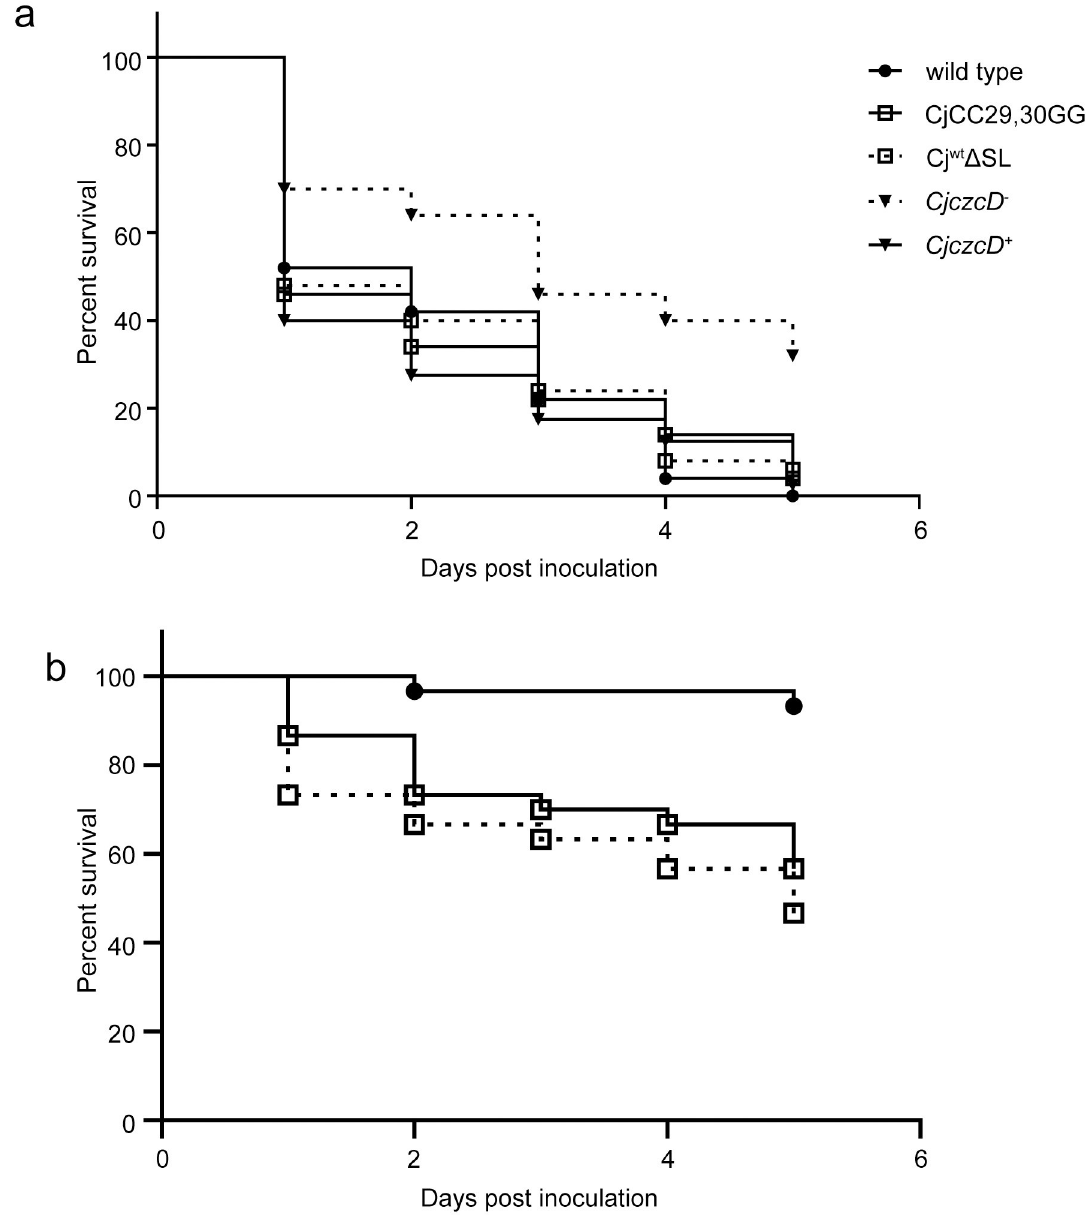
Fig 6. CzcD and associated temperature regulation are involved in Galleria mellonella larval killing. a. Strains of C . jejuni were grown in MH broth, washed twice in PBS and ~10 6 CFU injected into G . mellonella larvae that were incubated at 37˚C and scored daily for survival. Strains were wild-type NCTC 11168, czcD insertionally inactivated mutant (Cj czcD - ), the derived genetically complemented strain (Cj czcD + ), the derivative lacking SL czcD (Cj wt Δ SL) or with the derepressing mutation CC29,30GG (CjCC29,30GG). Data represent five biological replicates for all strains except Cj czcD + with four biological replicates. Each biological replicate consisted of injecting ten larvae (i.e. n = 50 or 40). Pairwise p values were calculated using a Log-rank (Mantel-Cox) test implemented in GraphPad Prism. Data for the Cj czcD - strain was statistically significantly different when compared to all four other strains with p values of < 0.0001, < 0.0001, 0.0001 and 0.0004 for the wild-type, Cj czcD + , CjCC29,30GG and Cj Δ SL comparisons, respectively. No other pairwise comparisons were statistically significant. b. Similar experiment as for (a) except C . jejuni strains were grown and larvae incubated at 32˚C, and larvae were injected with ~10 7 CFU. Data represent three biological replicates with ten larvae per experiment per strain (n = 30). P values were calculated as in (a). The results obtained for pairwise comparison of the wild-type with CjCC29,30GG and Cj Δ SL strains were statistically significant with p values of 0.0009 and < 0.0001, respectively. There was no statistically significant difference between the CjCC29,30GG and Cj Δ SL